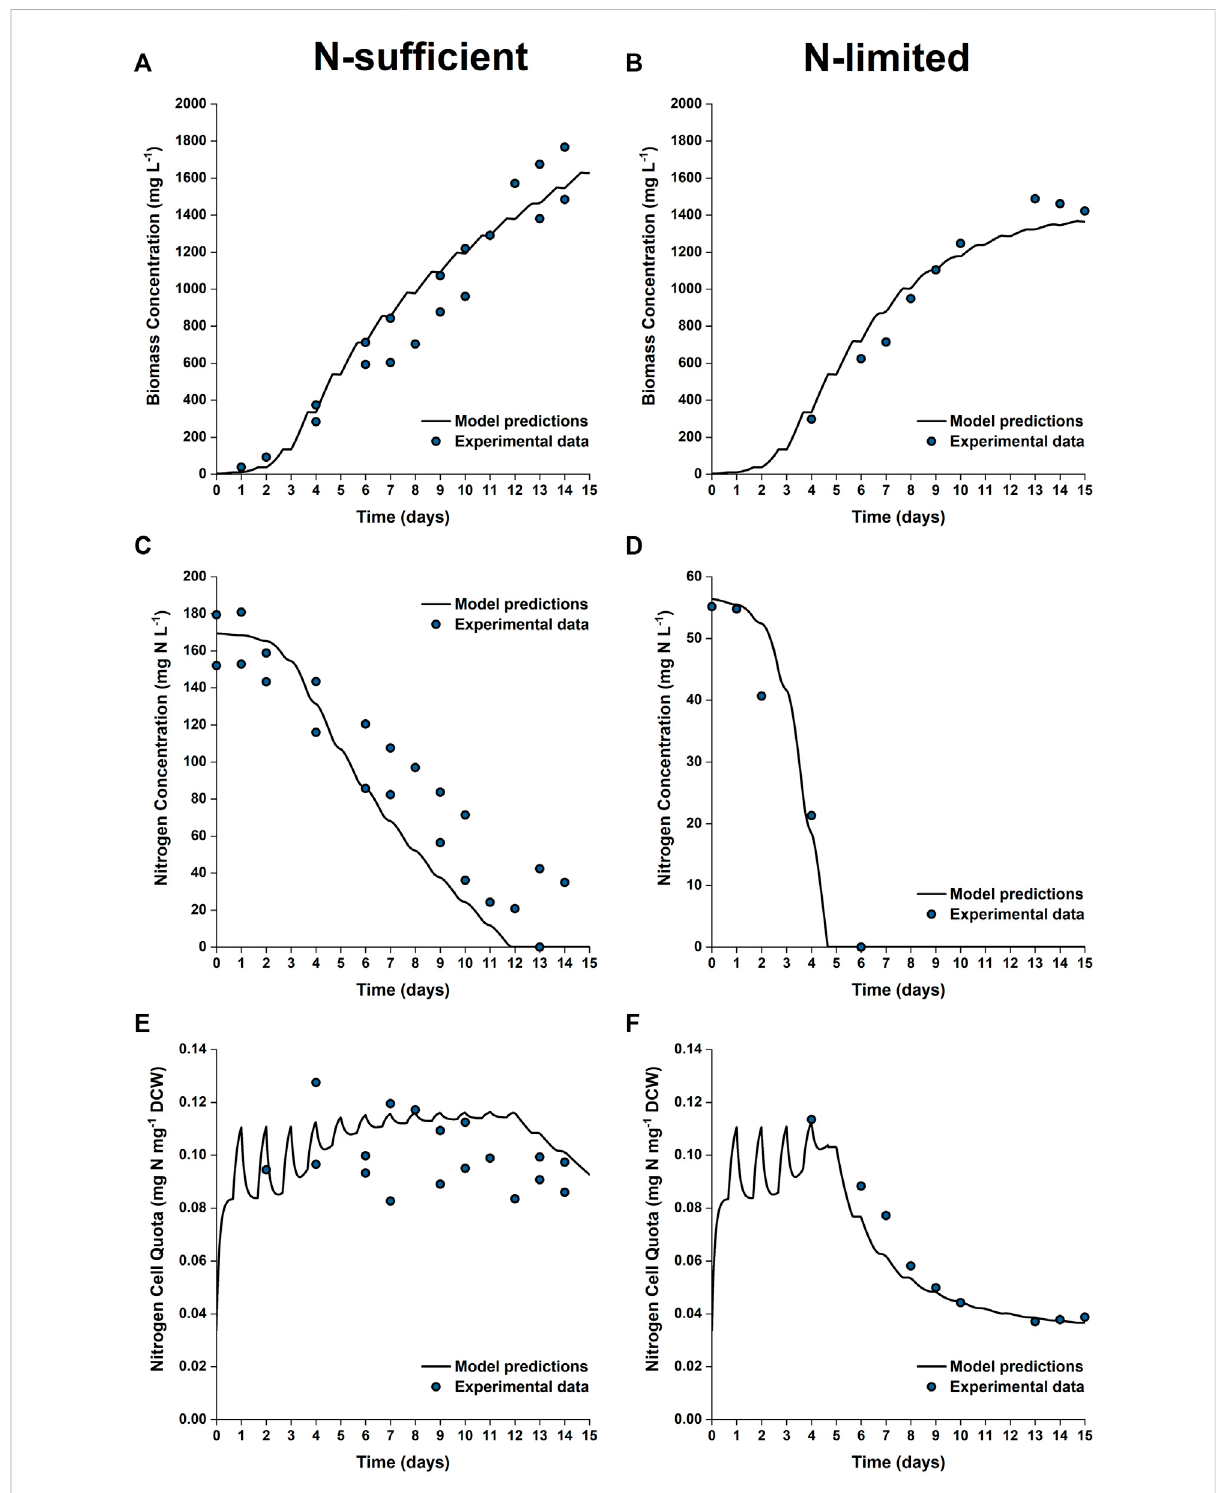
FIGURE 7 Comparison between experimentally measured and model predicted biomass concentration (A,B) , nitrogen concentration in the growth medium (C,D) and intracellular nitrogen cell quota (E,F) of P. tricornutum grown under N-suf fi cient (A,C,E) and N-limited (B,D,F) conditions. Batch cultures were grown in 50 L bubble column PBRs, with two biologically independent replicates for N-suf fi cient conditions and one for N-limited